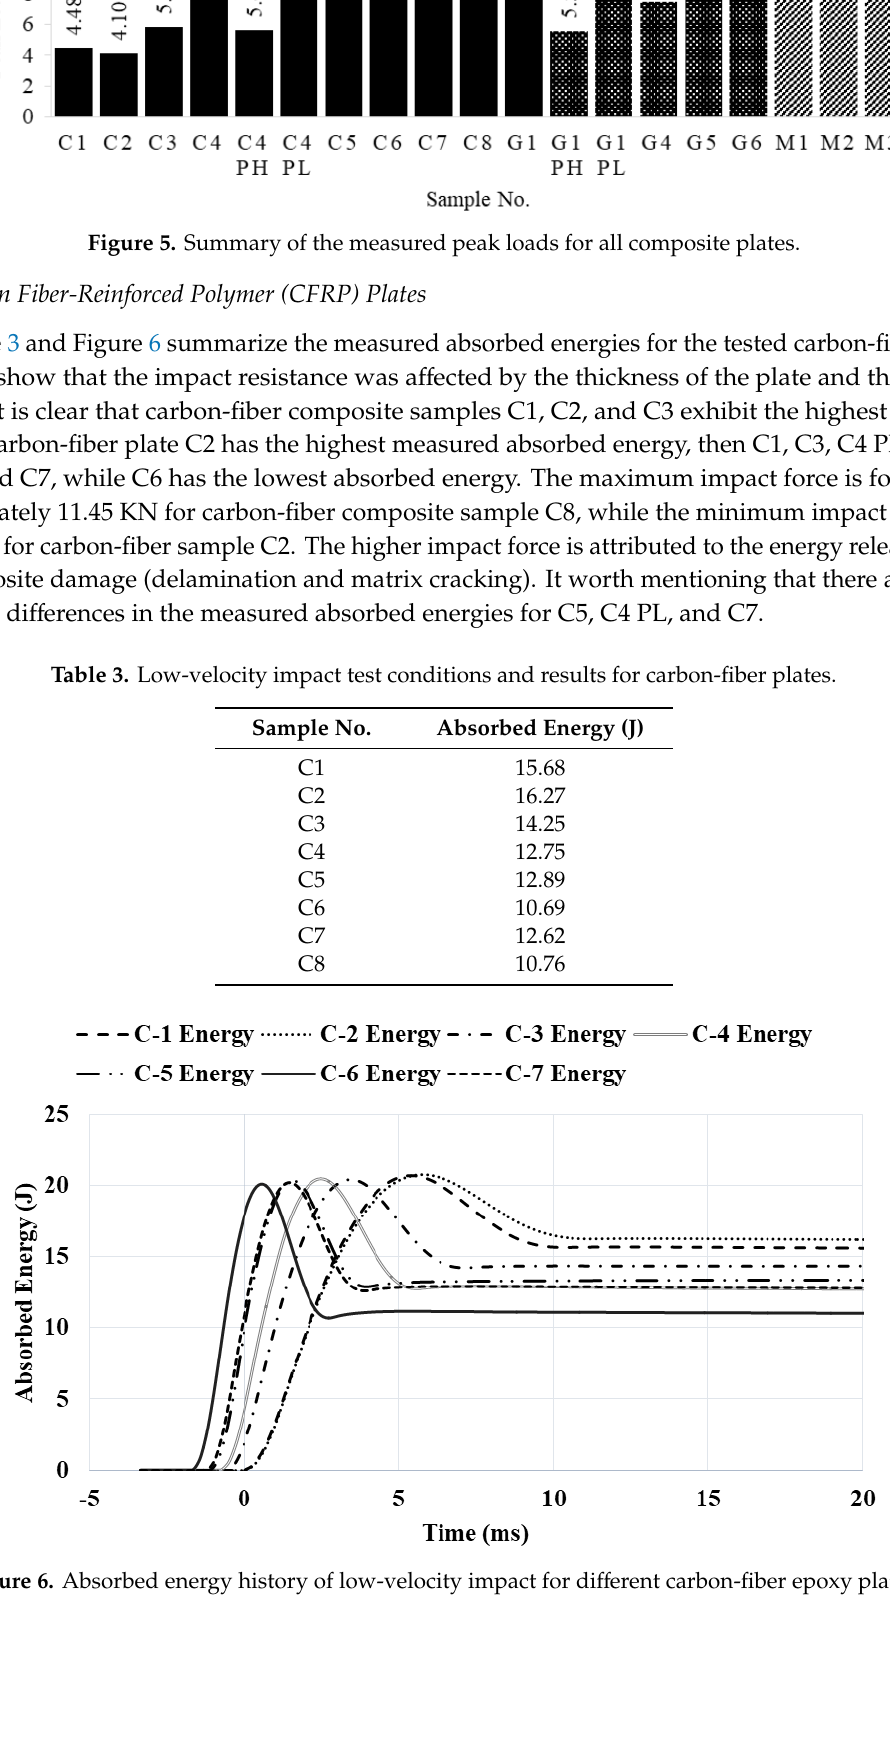
Figure 4. Summary of the measured absorbed energy for all composite plates.